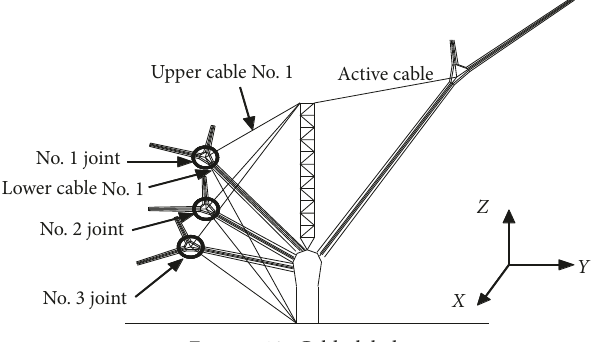
Figure 12: Cable